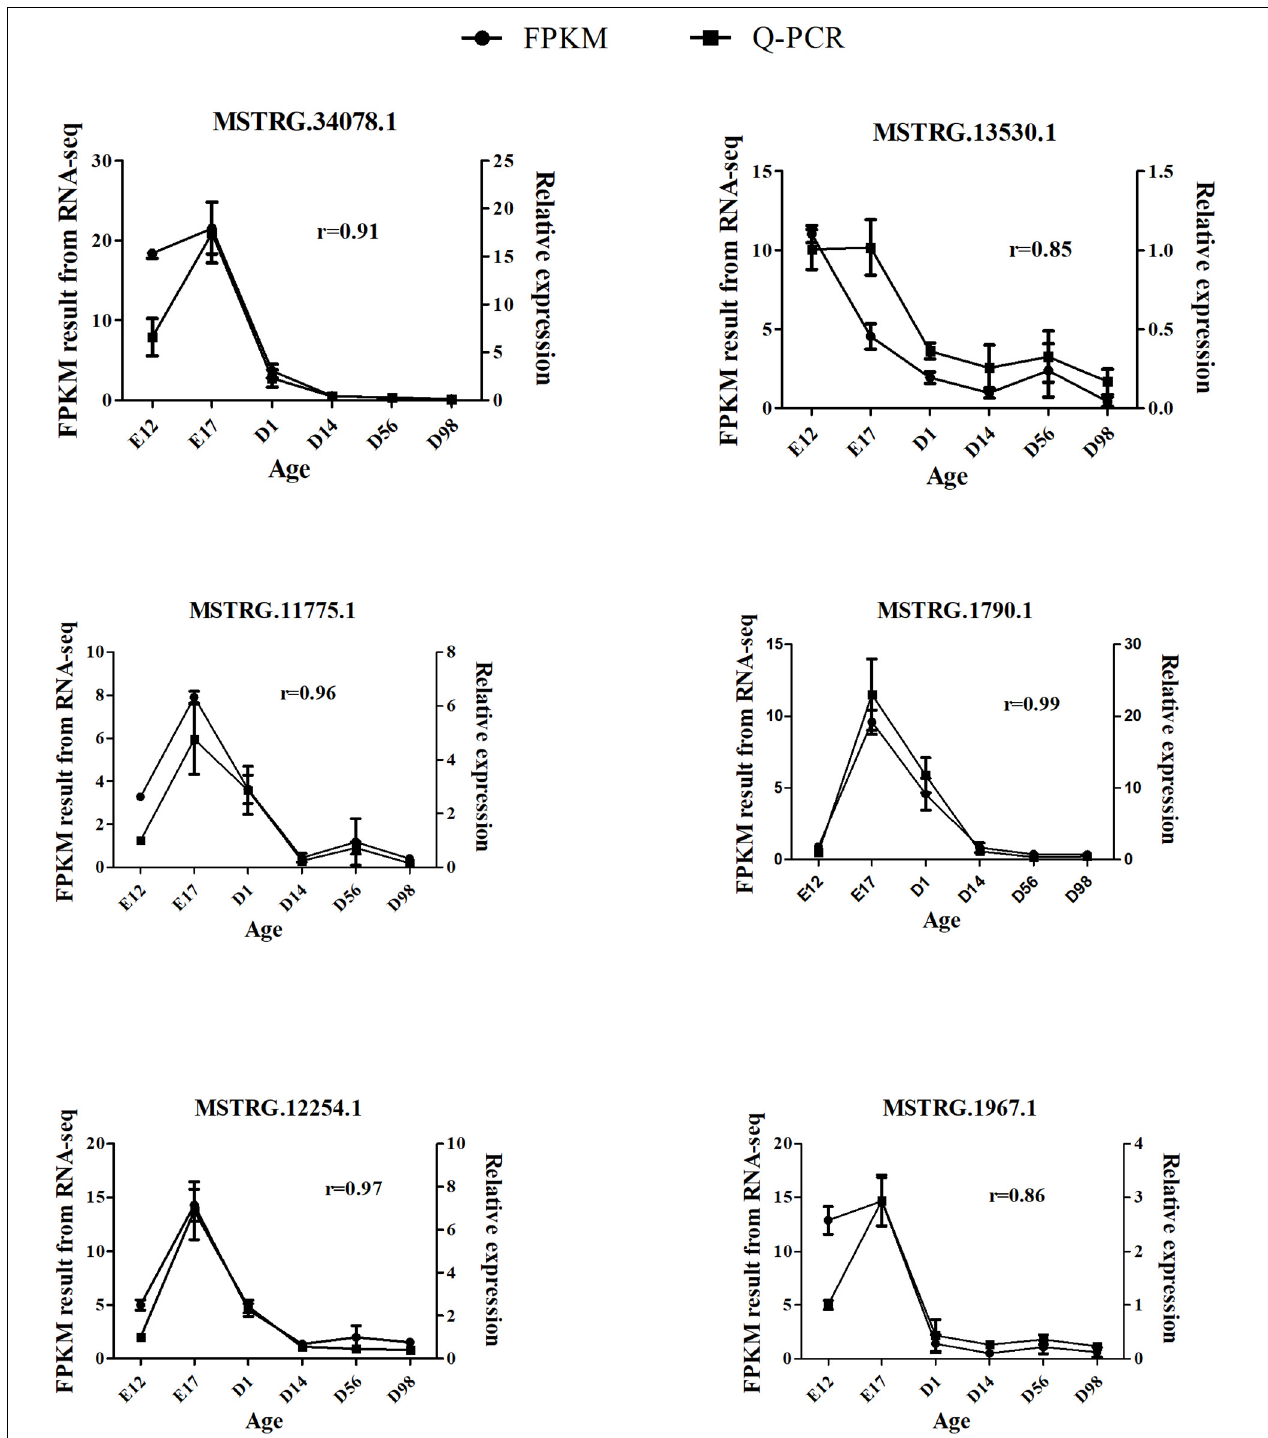
FIGURE 4 | Validation of six DE-lncRNAs by qRT-PCR. The r value represents the Pearson correlation coefficient between two methods.